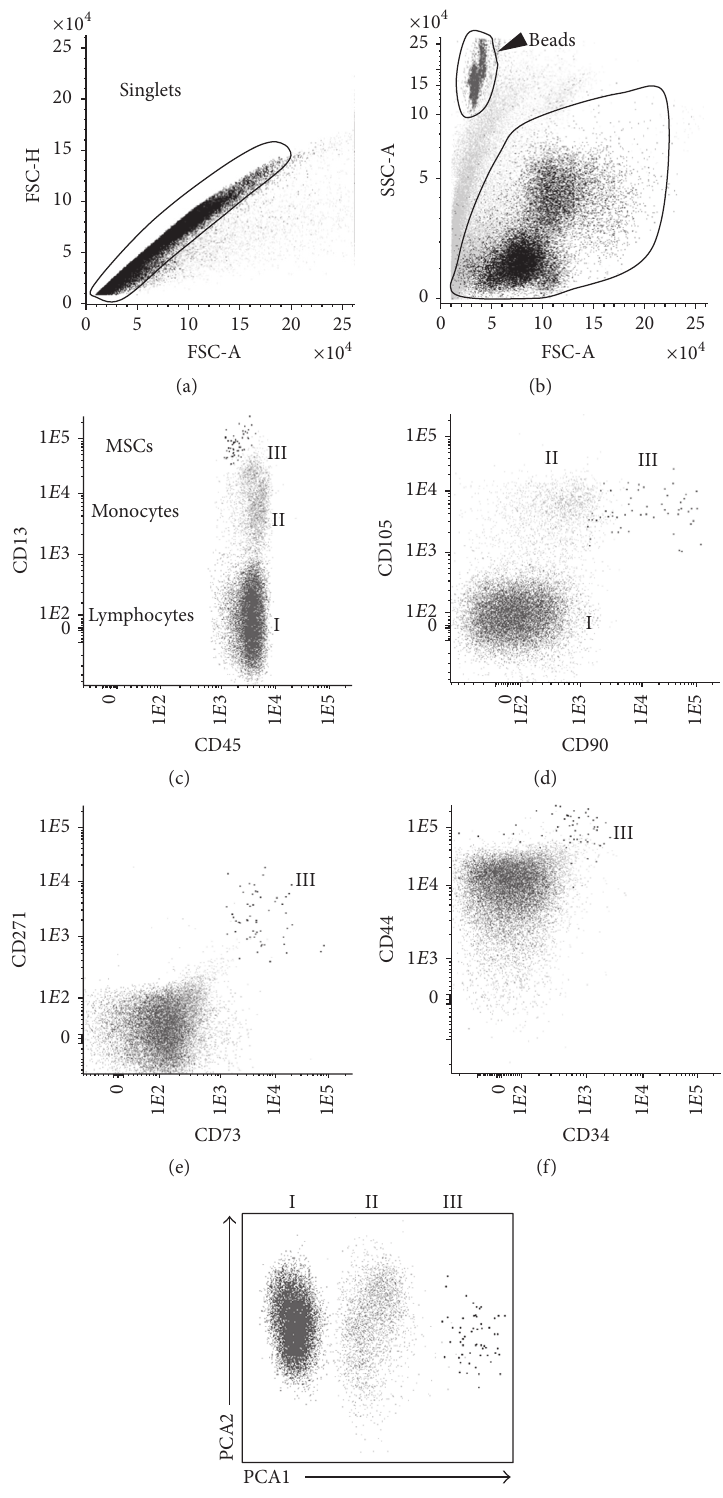
Figure 1: Phenotypic characterization of synovial fluid MSCs. After exclusion of doublets (a) and debris (b), mesenchymal stem cells (MSCs) were identified through a Boolean gating strategy according to their strong reactivity for CD13, CD44, CD73, CD90, and CD105 and intermediate to high levels of CD271 (e-f), in the absence of CD34 (f). Monocytes were defined on the basis of their relatively higher light scatter properties and CD13 and CD45 bright expression, whereas lymphocytes were identified through low scatter properties and strong CD45 reactivity. In panel (g), the automated population separator (APS) graphic representation of the Infinicyt software is shown with the three cell populations phenotypically separated by principal component analysis (PCA). I: lymphocytes; II: monocytes; III: